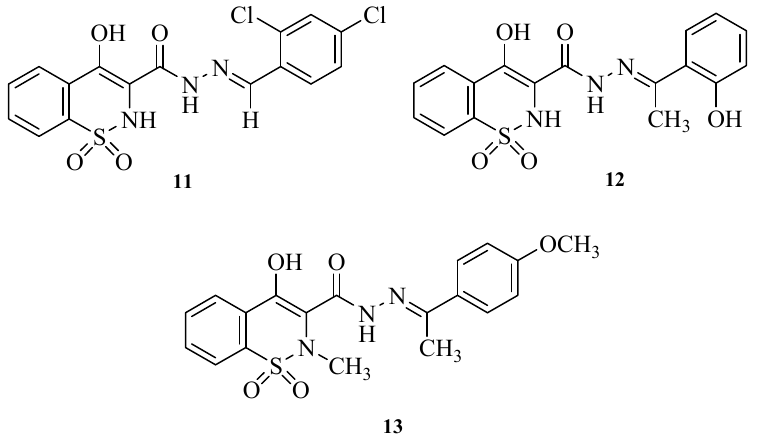
Figure 3. Antioxidant and antimicrobial N -acylhydrazones bearing a 4-hydroxy-1,2- benzothiazine-1,1-dioxide